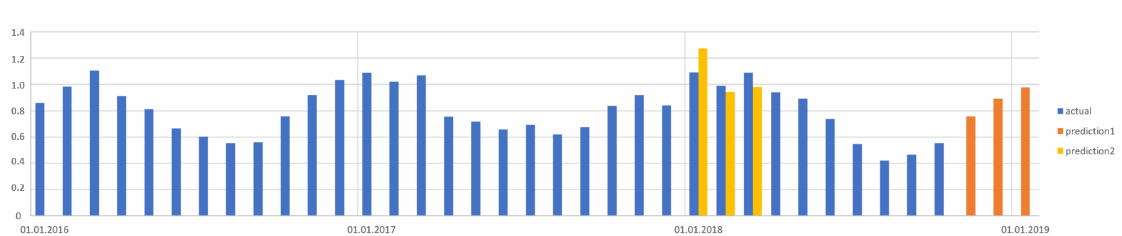
Figure 9. The actual and forecasted gas demand (mlnL) for 749